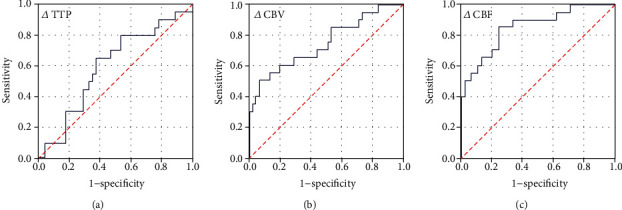
ROC analysis for each hemodynamic parameter correlated with clinical outcome. Results showed that diagnostic accuracy of ΔTTP was low (AUC = 0.597). As for ΔCBV, the AUC was 0.743 (95% CI, 0.605–0.881, p = 0.002), with the best threshold of 66.35 (sensitivity = 0.5, 1–specificity = 0.067, Yoden's index: 0.433). Similarly, the AUC was 0.852 for ΔCBF (95% CI, 0.750–0.954, p < 0.01), and the best threshold was 62.06 (sensitivity = 0.85, 1–specificity = 0.067, Yoden's index: 0.606).